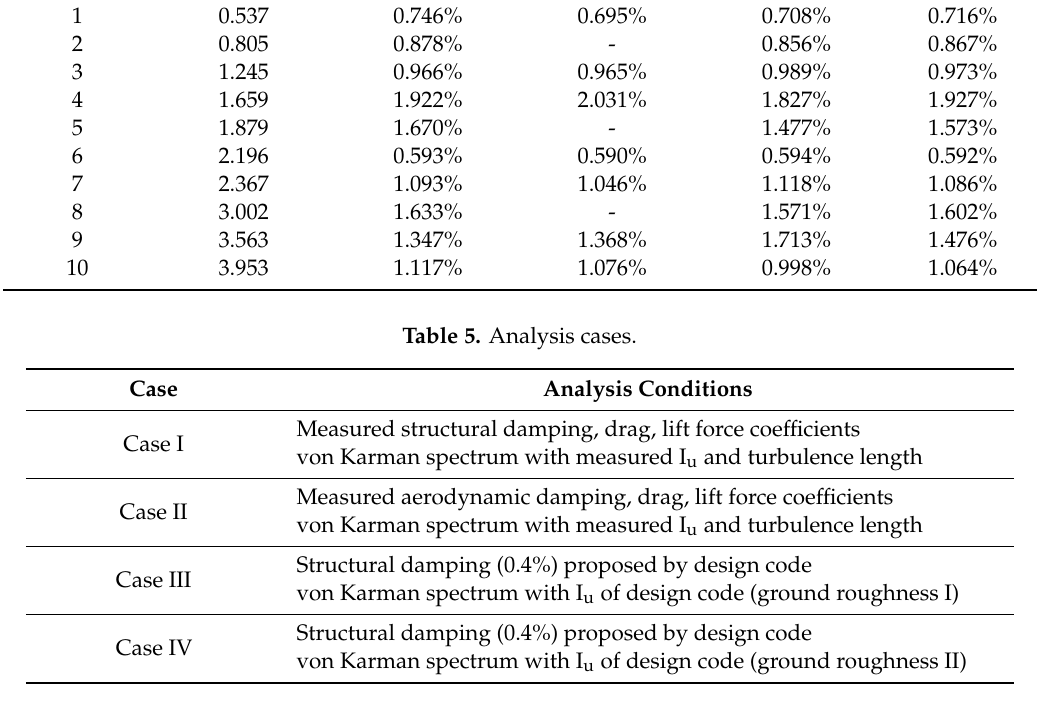
Table 6. Static force coe ffi cients obtained from measured